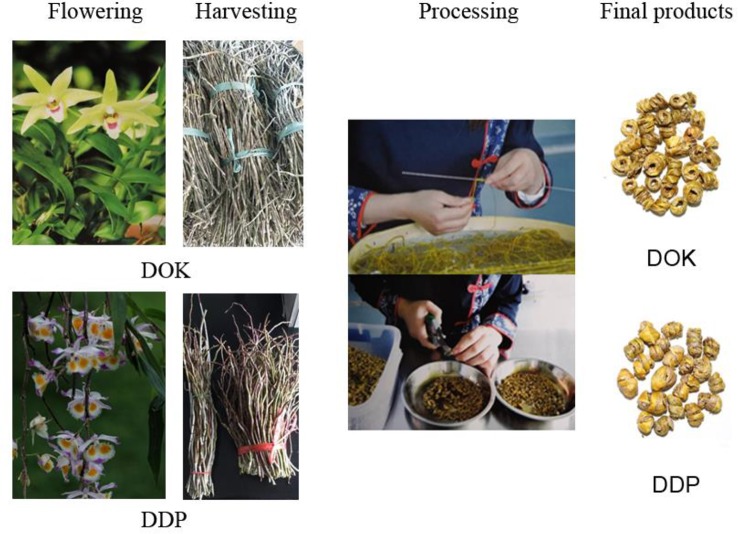
Schematic diagram of the fengdou processing.